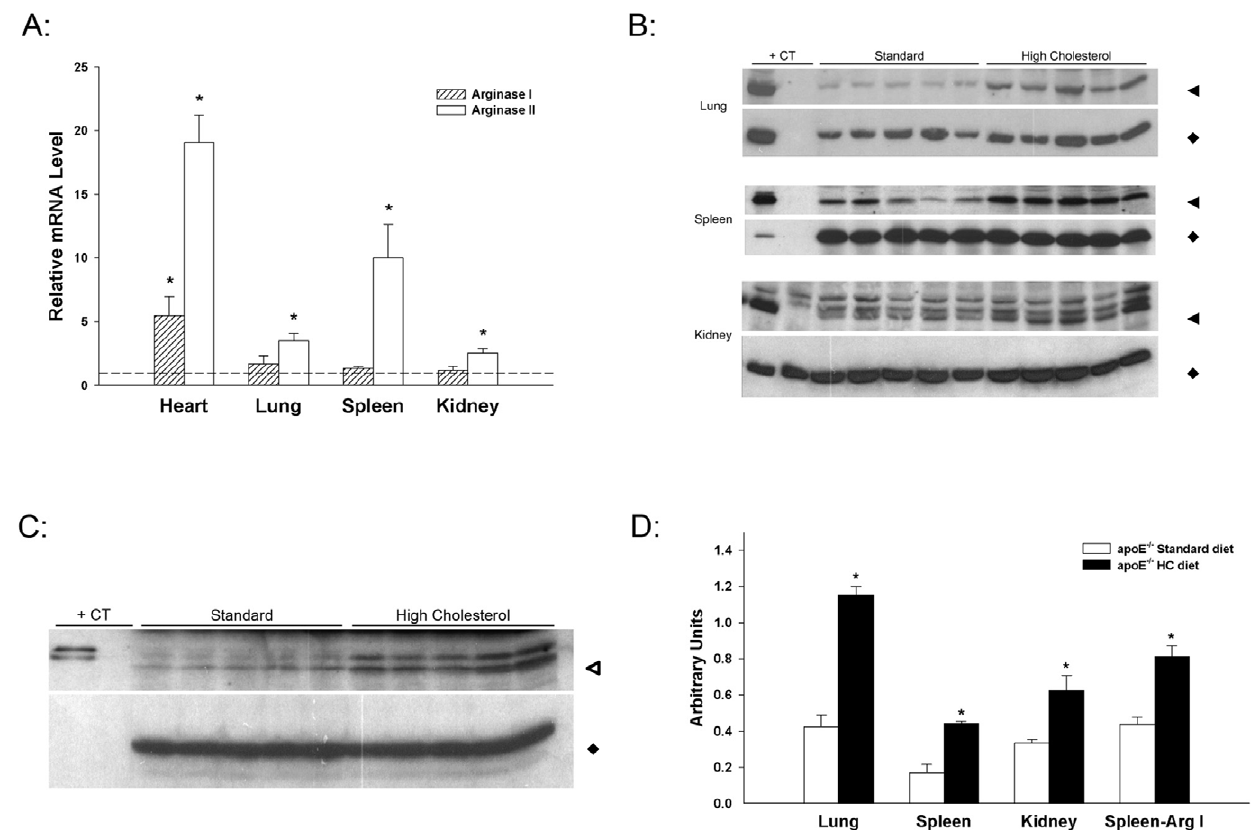
Figure 7. Induction of arginase mRNA and protein in apoE 2 / 2 mice on HC diet. (A) Effect of HC diet on arginase I and II mRNAs in heart, lung, spleen and kidney. mRNA levels are expressed relative to the levels in apoE 2 / 2 mice on standard diet (arbitrarily set to 1.0 for each tissue and indicated by dotted line). Values are means 6 SE for n=5–7 in each group. *p , 0.05 vs standard diet. (B) Effect of HC diet on arginase II protein abundance in lung, spleen and kidney. For each tissue, the upper panel represents arginase II and the lower panel GAPDH. Western blots of extracts from tissues of 5 representative animals on each diet are shown. Amounts of protein loaded in each lane were 10 m g (lung and kidney) or 25 m g (spleen). An extract of C57BL/6J whole kidney (20 m g for lung and kidney blots, 3 m g for spleen blot) was used in the first lane of each blot as positive control ( + CT) for arginase II. Twenty m g protein from kidney of the arginase II knockout mouse [47] was included in the second lane of the kidney blot in order to establish identity of the lowest band as arginase II. (C) Effect of HC diet on arginase I protein abundance in spleen. The upper panel represents arginase I and the lower panel GAPDH. The Western blot represents extracts from spleen (50 m g each lane) of 5 representative animals on each diet and 100 ng of C57BL/6J liver extract ( + CT) as positive control. (D) Densitometry of Western blots, represented in arbitrary units (Arginase/ GAPDH), was analyzed by Image Quant 5.2 Software. *p , 0.01 vs standard diet. Molecular weights are indicated by the following symbols: solid triangles, 39 kDa; solid diamonds, 37 kDa; open triangles, 37